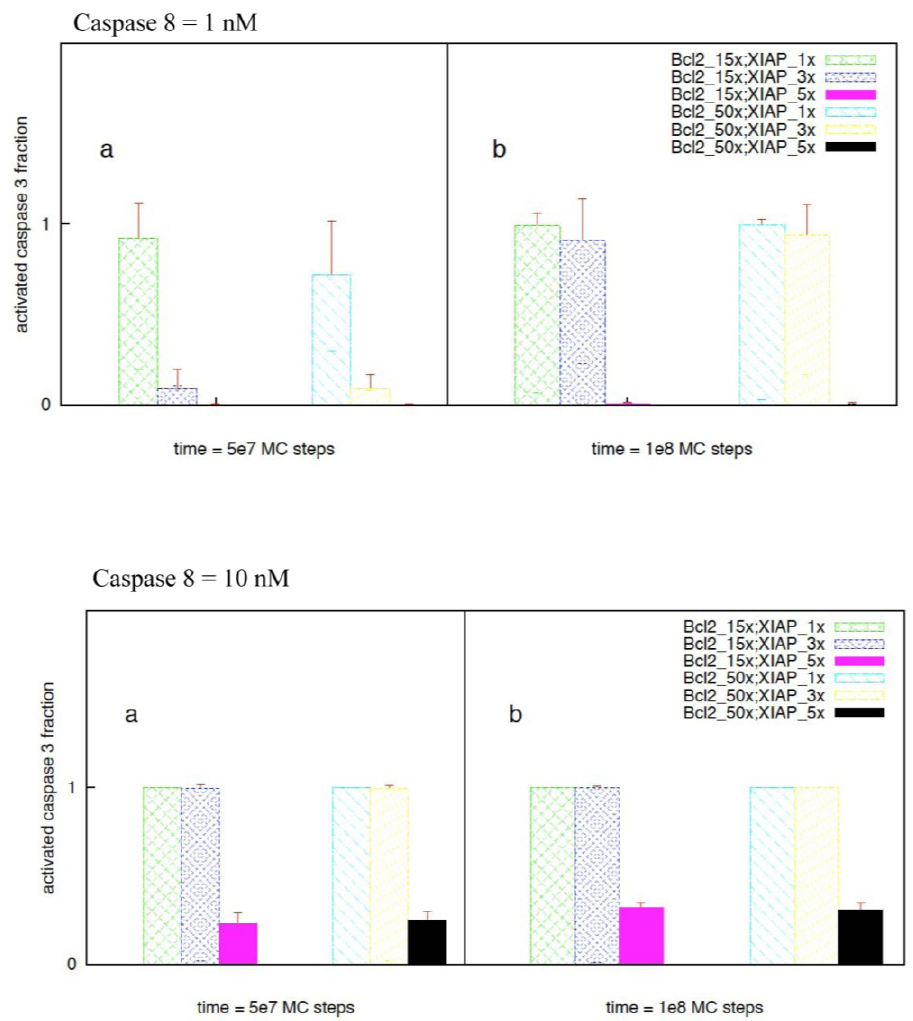
Figure 13. Activated caspase 3 (fraction of half-maximal activation) for various combinations of Bcl2 (15- and 50-fold) and XIAP overexpression (normal, 3-fold and 5-fold). Two different values of initial caspase 8 concentration are studied: 1 nM (top) and 10 nM (bottom). Data obtained from 60–64 single cells (MC runs) are shown for two different time instants: 5 × 10 7 ( a ) and 1 × 10 8 ( b ) MC